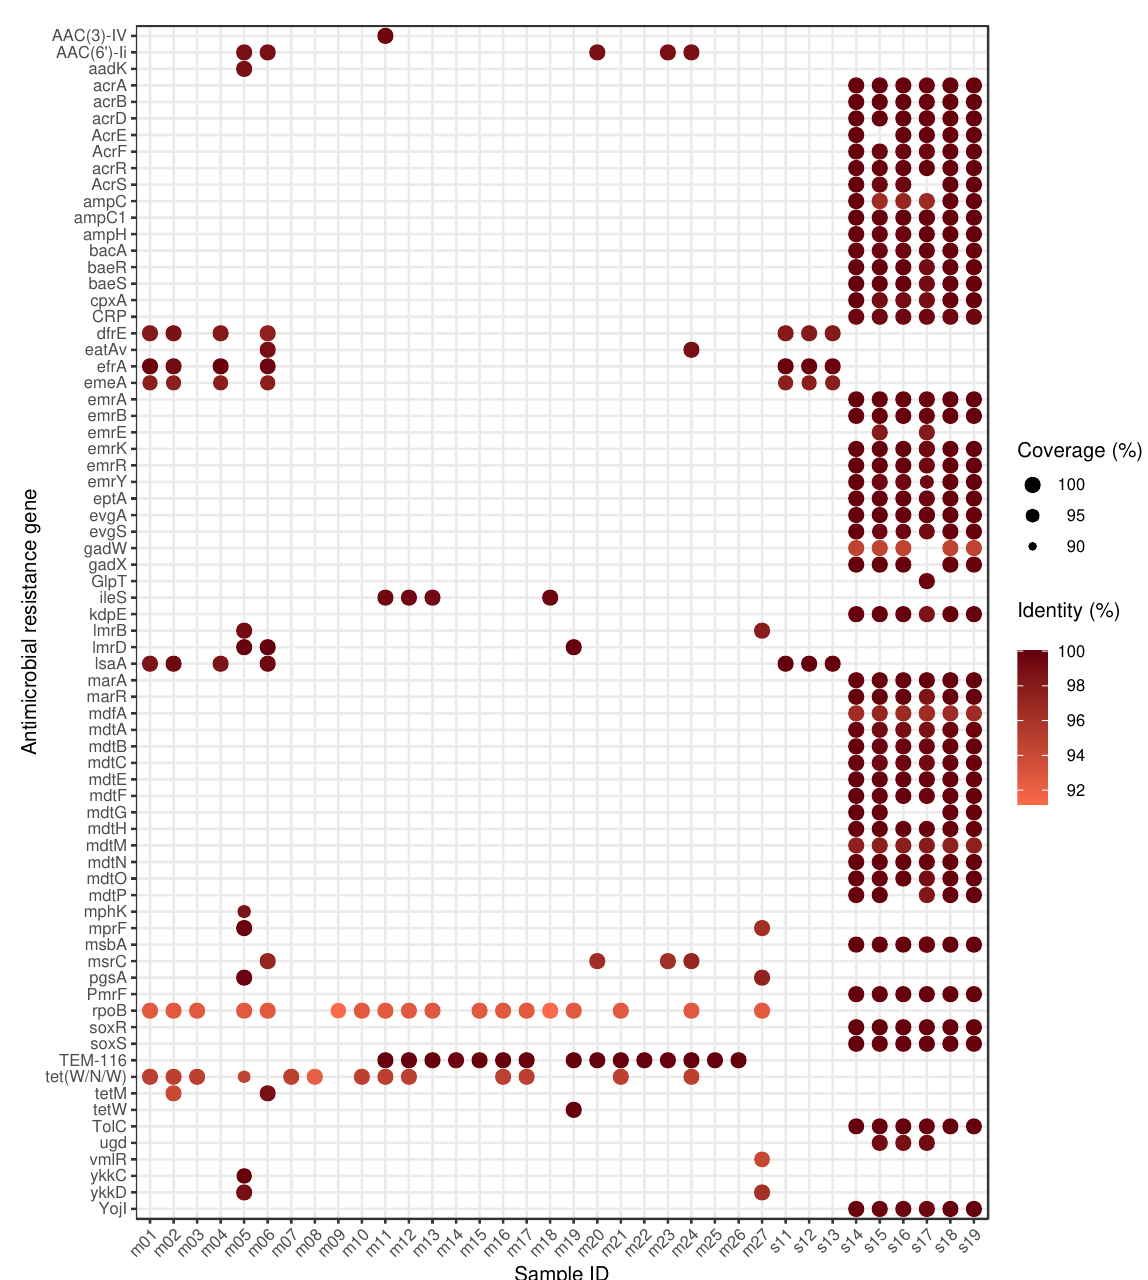
Figure 2. Identifed antimicrobial resistance genes (ARGs) by samples. For each sample–ARG combination, only the best finding is plotted. The size and the colour of the dots correspond to the coverage and the sequence identity of hits on reference genes, respectively. In samples s01–s10 and s20, there was no identifiable ARG. The gene names that are too long have been abbreviated ( acrA : Escherichia coli acrA ; acrR : E. coli acrR with mutation conferring multidrug antibiotic resistance; ampC : E. coli ampC beta-lactamase; ampC1 : E. coli ampC1 beta-lactamase; ampH : E. coli ampH beta-lactamase; emrE : E. coli emrE ; GlpT : E. coli GlpT with mutation conferring resistance to fosfomycin; ileS : Bifidobacterium bifidum ileS conferring resistance to mupirocin; marR : E. coli marR mutant conferring antibiotic resistance; mdfA : E. coli mdfA ; mprF : Bacillus subtilis mprF ; pgsA : B. subtilis pgsA with mutation conferring resistance to daptomycin; rpoB : Bifidobacterium adolescentis rpoB mutants conferring resistance to rifampicin; soxR : E. coli soxR with mutation conferring antibiotic resistance; soxS : E. coli soxS with mutation conferring antibiotic